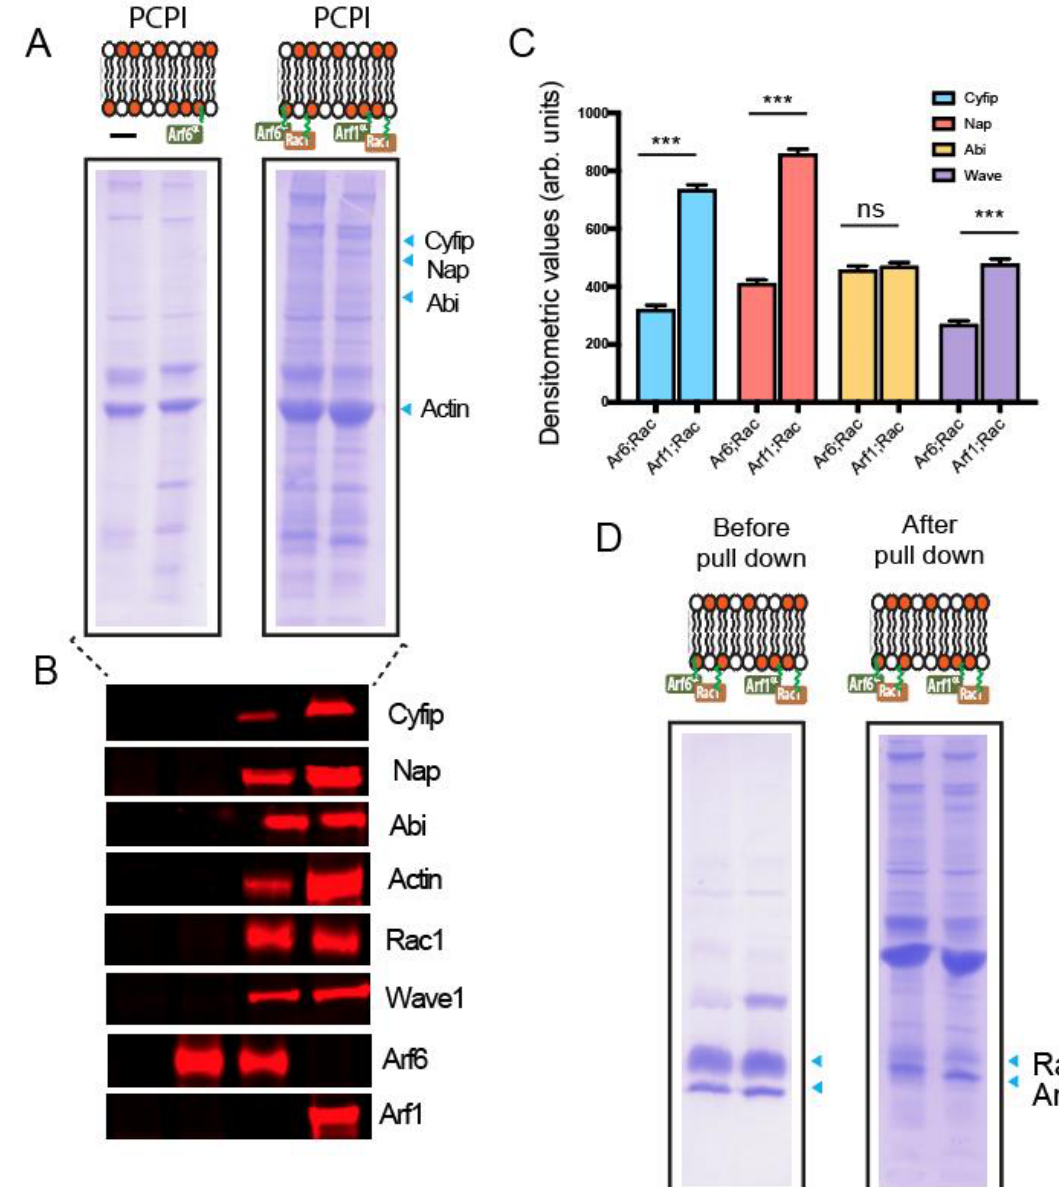
Figure 2. Coomassie blue staining depicting recruited protein from porcine brain extract on control (-), Arf6QL, Arf6QL; Rac1QL and Arf1QL; and Rac1QL anchored PCPI lipid bilayers ( A ). ( B ) Immunoblotting of samples from ( A ) with indicated antibodies. ( C ) Densitometric quantification of the wave-regulatory complex component bands recruited on Arf6QL; Rac1QL and Arf1QL; and Rac1QL anchored PCPI lipid bilayers as described in ( A ). ( D ) Coomassie blue staining depicting recruited proteins before and after incubating the Arf6QL; Rac1QL and Arf1QL; Rac1QL anchored PCPI lipid bilayers in brain extract. *** p < 0.001 (one-way ANOVA followed by a post hoc Dunnett comparison) relative to the control.